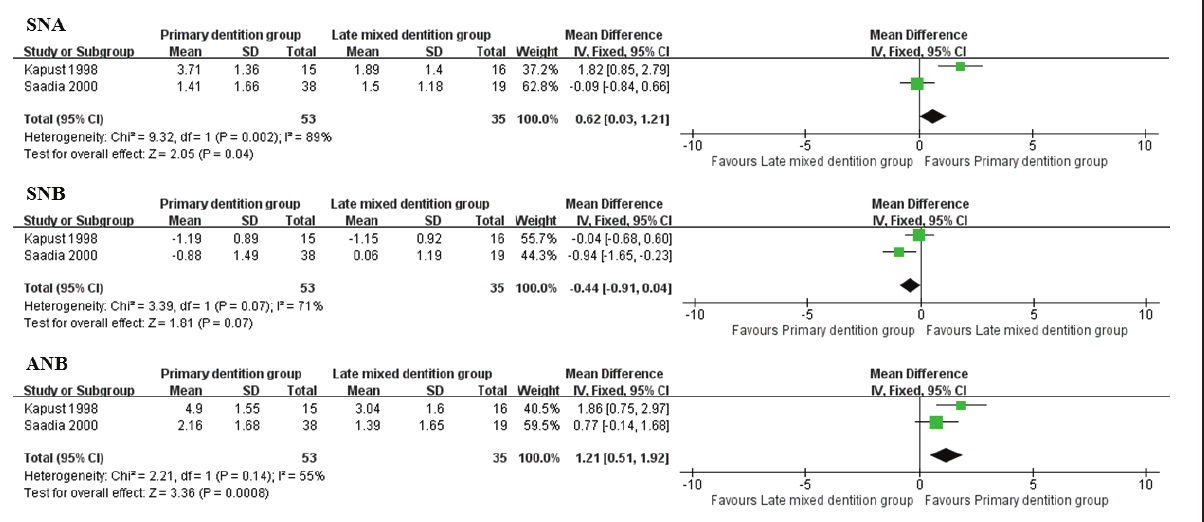
Figure 6. Meta-analysis between primary dentition and late mixed dentition. The efficacy assessment of the primary dentition group for Class III malocclusion versus the late mixed dentition group. The comparison was performed us- ing three indices. 1: Angle SNA. The primary dentition group presented a greater increase in SNA than the late mixed dentition group (MD = 0.62, 95% CI = 0.03 – 1.21, P = 0.04). 2: Angle SNB. There were no significant differences in SNB between the two groups (MD = -0.44, 95% CI = -0.91 – 0.70, P = 0.04). 3: Angle ANB. The primary dentition group presented a greater increase in ANB than the late mixed dentition group (MD = 1.21, 95% CI = 0.51 – 1.92, P <